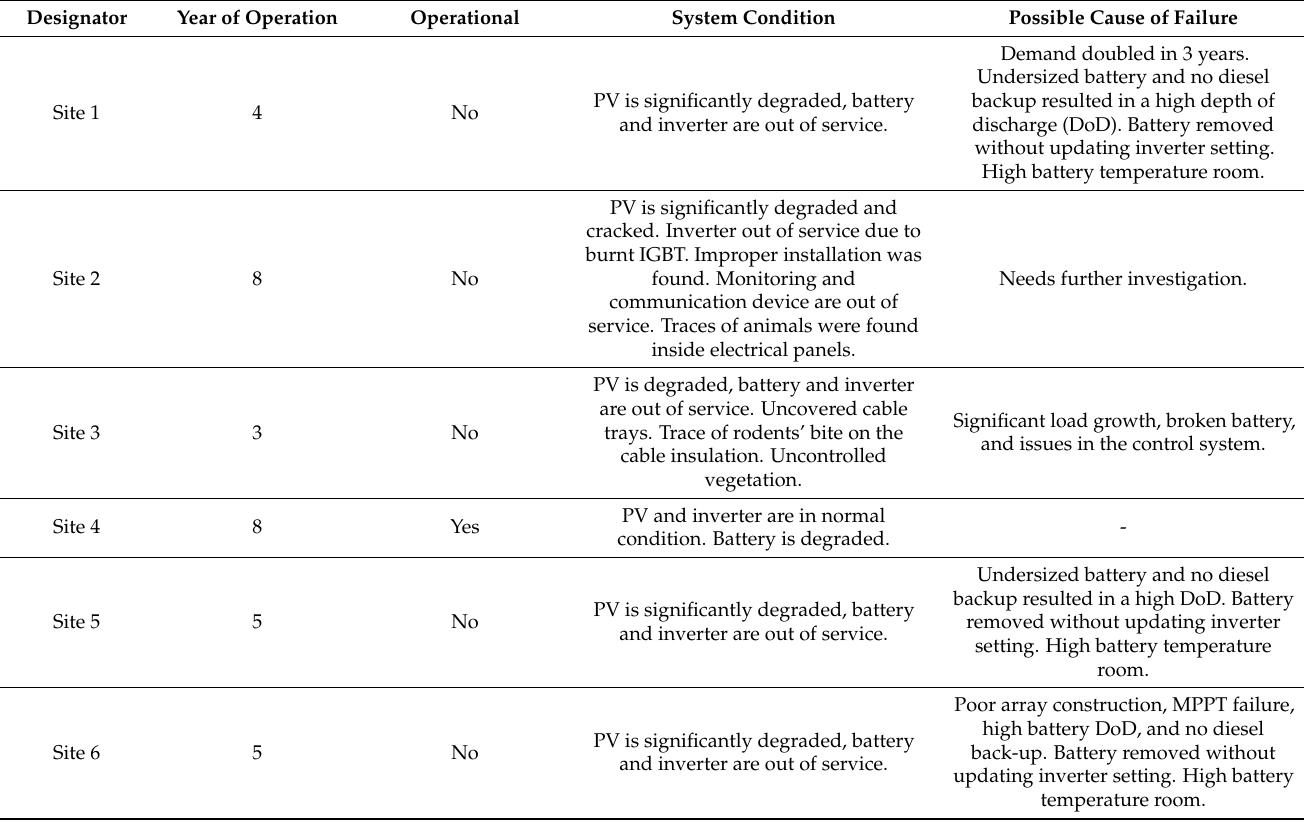
Table 2. The operation status of the observed PV and PV hybrids in